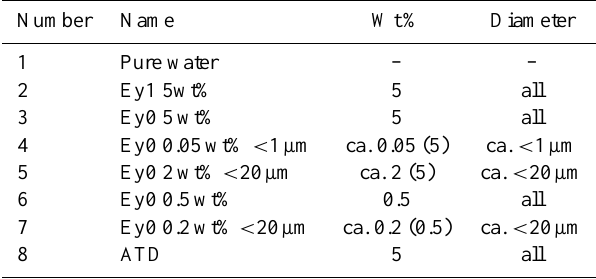
Table 1. Several suspensions of the ash were created, and the freez- ing temperature of different samples of these suspensions were in- vestigated. The names by which the different suspensions are re- ferred to in the text are listed below, along with the details of the suspension: weight percent of ash in the suspension and the approx- imate largest diameter of ash particles remaining in the suspension after settling. If no settling was carried out, all diameters from the ash sample are assumed to be represented. For the settled samples, the weight percents are the estimated weight percent after settling, with the weight percent of ash in the sample before settling given in